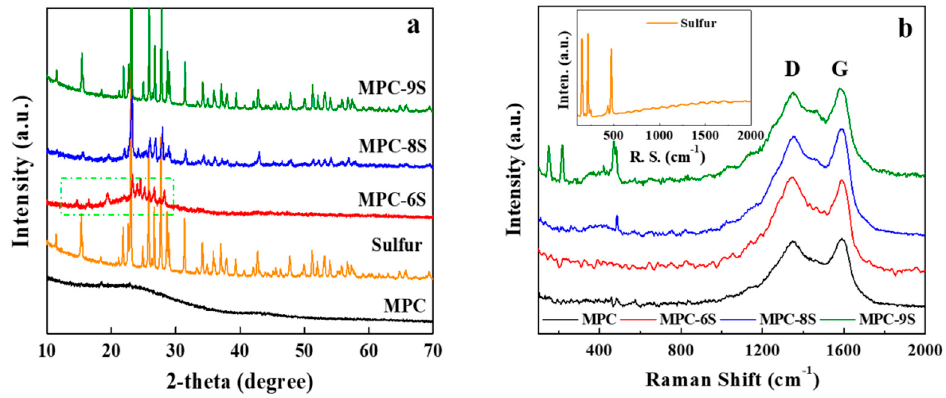
Figure 3. ( a ) XRD patterns and ( b ) Raman spectra of MPC, elemental sulfur, and MPC-sulfur composites with different sulfur contents (inset: Raman spectrum of elemental sulfur).